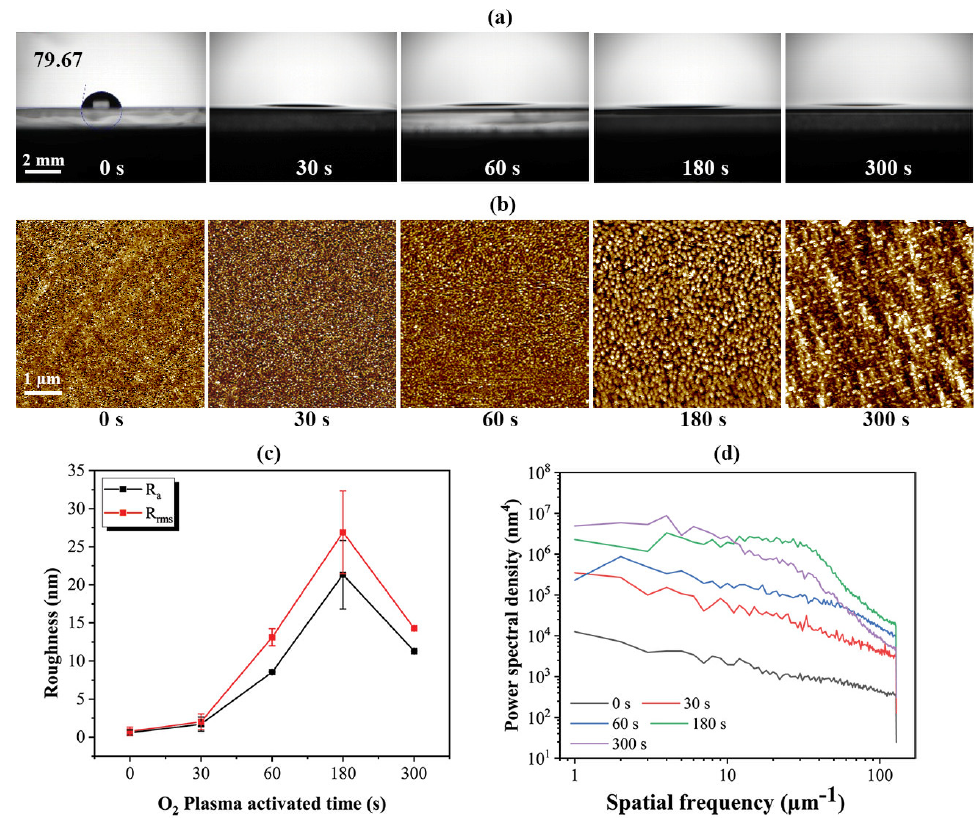
Figure 5. ( a ) Contact angle, ( b ) AFM results, ( c ) R rms and R a roughness, and ( d ) power spectral density of the polyimide surface after plasma activation of different periods.